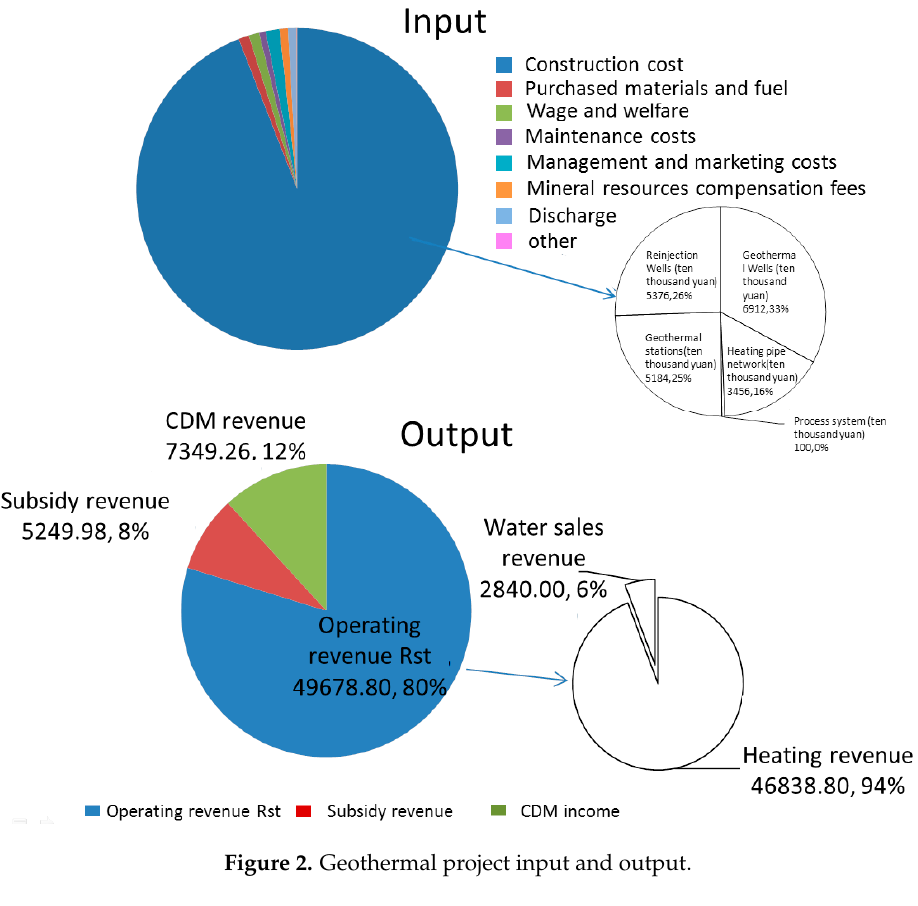
Figure 2. Geothermal project input and output.